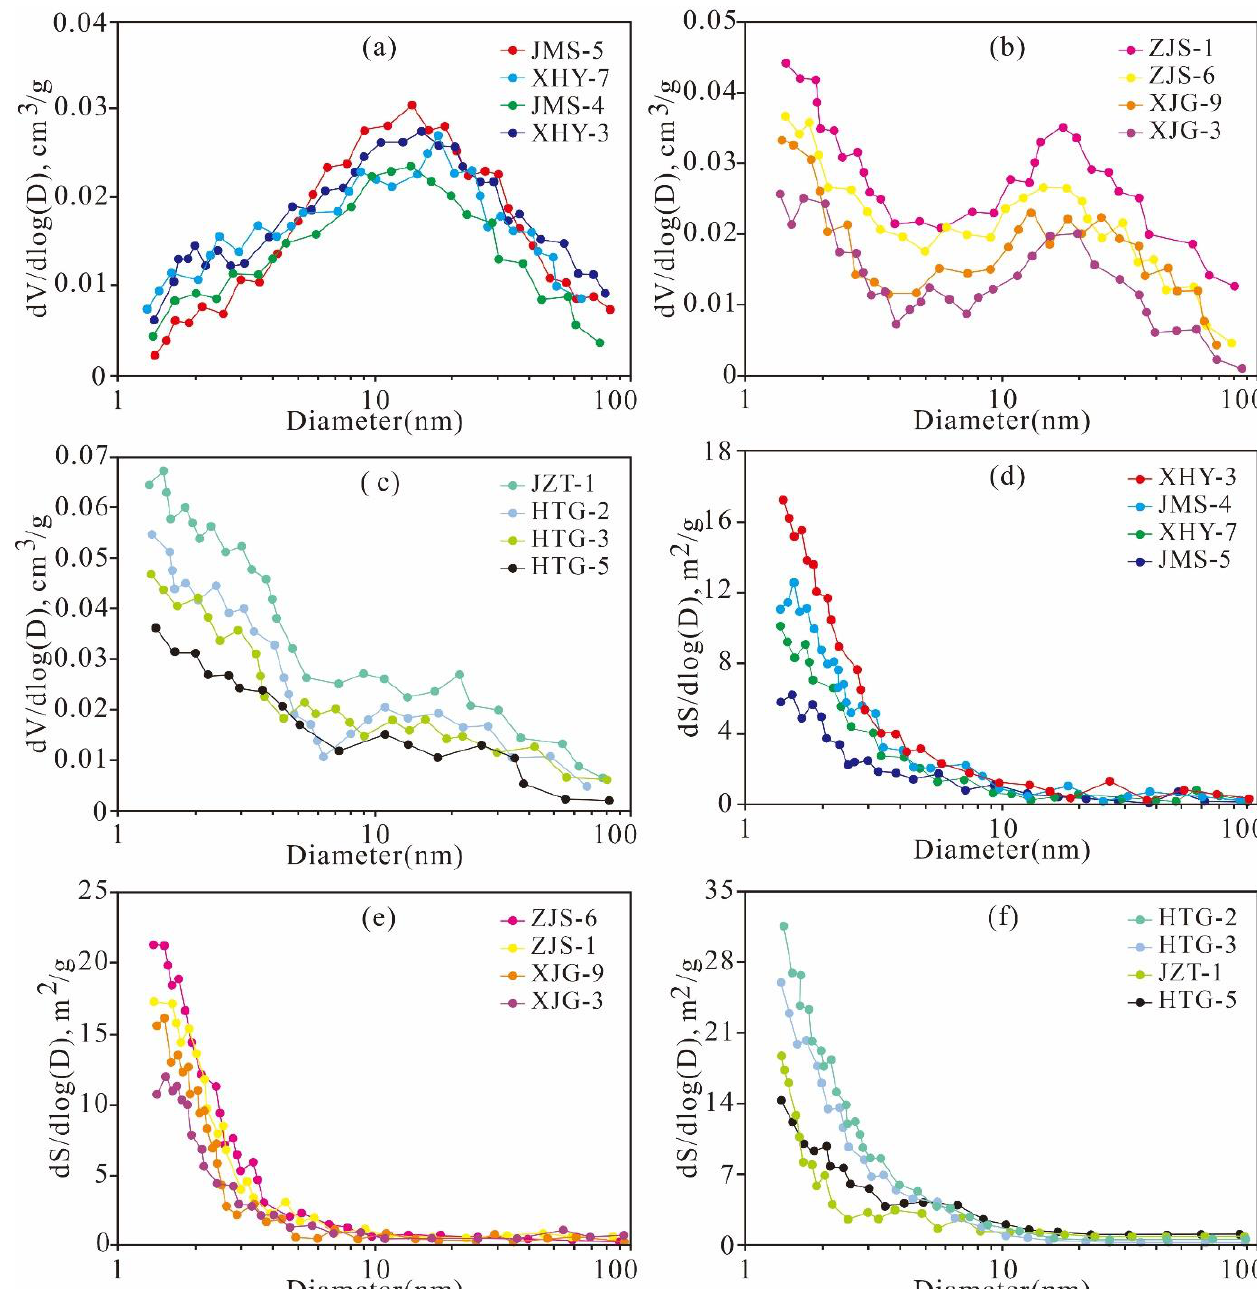
Figure 4. PV ( a – c ) and SA ( d – f ) distribution with pore size derived from the N 2 adsorption branch for the isotherms of representative samples of Mesoproterozoic Xiamaling shale in Zhangjiakou, Hebei.